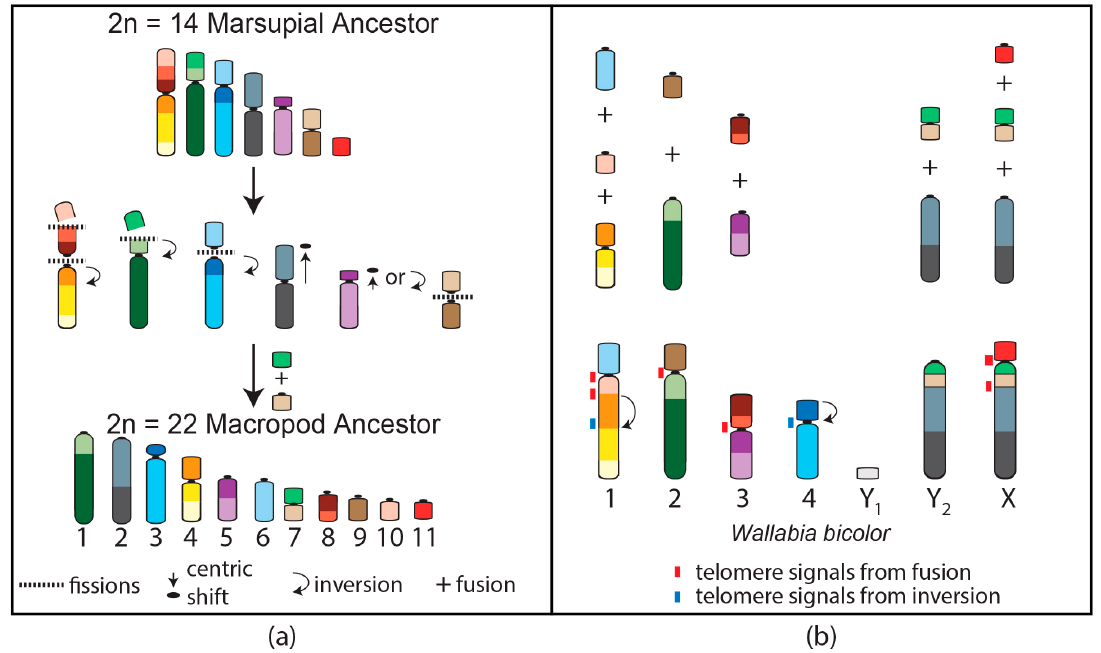
Figure 3. Chromosome rearrangements resulting in the ( a ) macropod 2 n = 22 ancestral karyotype from the 2 n = 14 ancestral marsupial and ( b ) the rearrangements of the ancestral macropod chromosomes to result in the 2 n = 10 female, 11 male karyotypes of the swamp wallaby ( W. bicolor ).